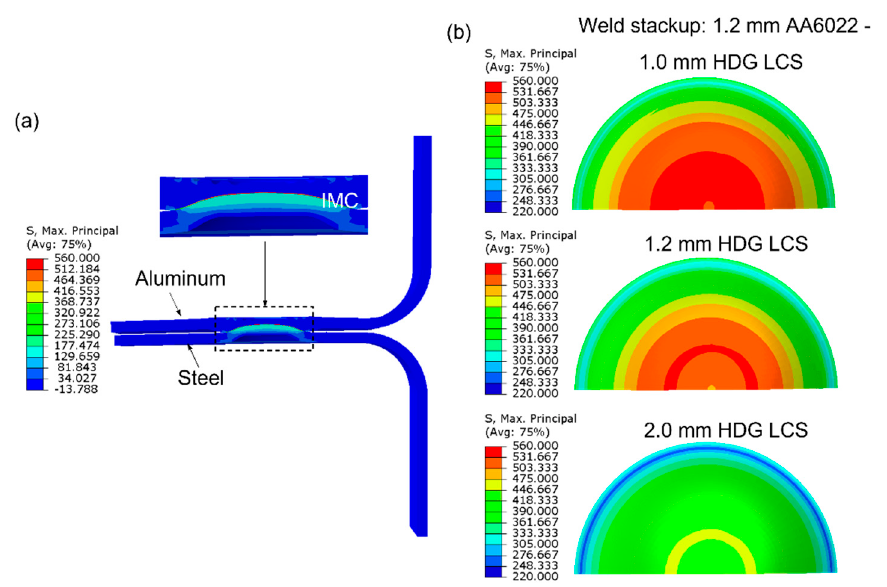
Figure 5. Numerical results of ( a ) thermal stress distribution in a single joint RSW specimen and ( b ) the variation of thermal stress in IMC layer with increased thickness of steel plate under baking process.